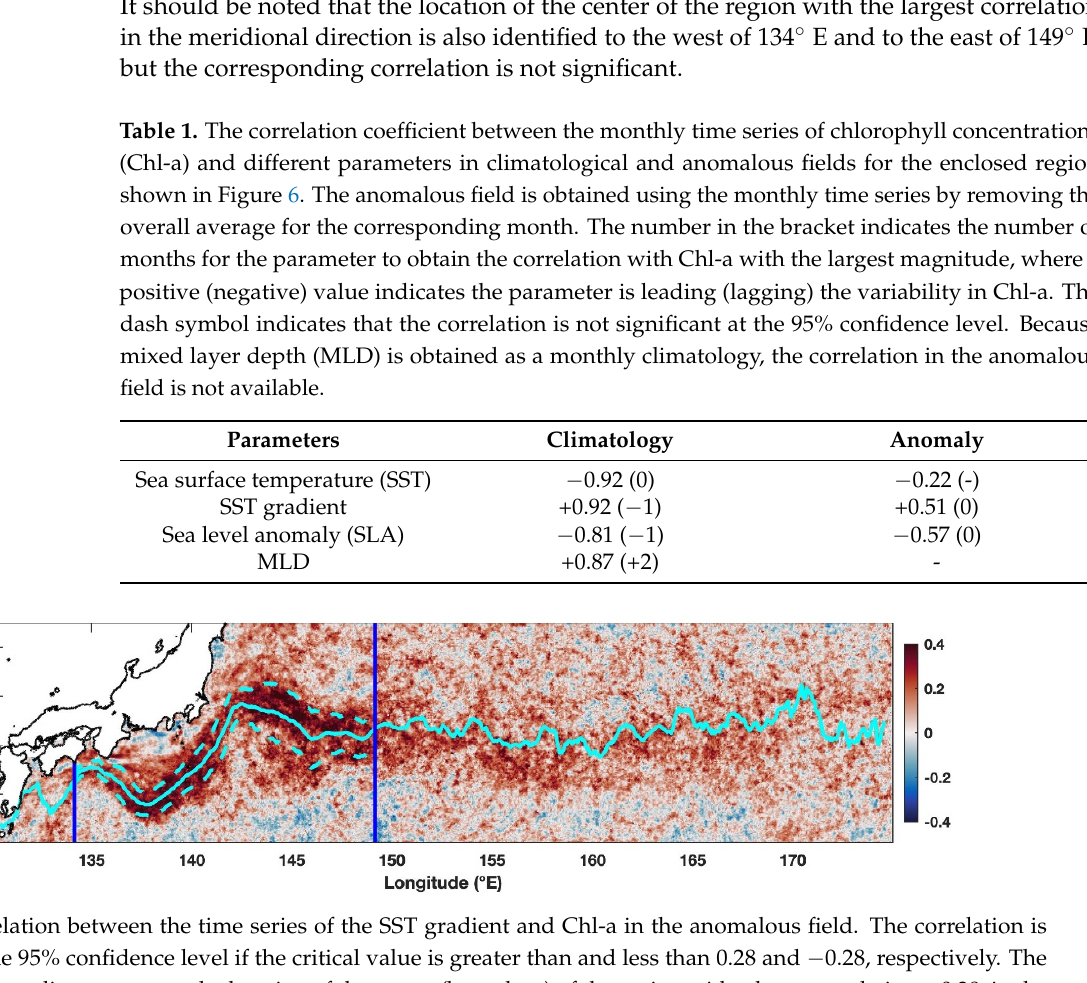
Table 1. The correlation coefficient between the monthly time series of chlorophyll concentrations (Chl-a) and different parameters in climatological and anomalous fields for the enclosed region shown in Figure 6. The anomalous field is obtained using the monthly time series by removing the overall average for the corresponding month. The number in the bracket indicates the number of months for the parameter to obtain the correlation with Chl-a with the largest magnitude, where a positive (negative) value indicates the parameter is leading (lagging) the variability in Chl-a. The dash symbol indicates that the correlation is not significant at the 95% confidence level. Because mixed layer depth (MLD) is obtained as a monthly climatology, the correlation in the anomalous field is not available. Parameters Climatology